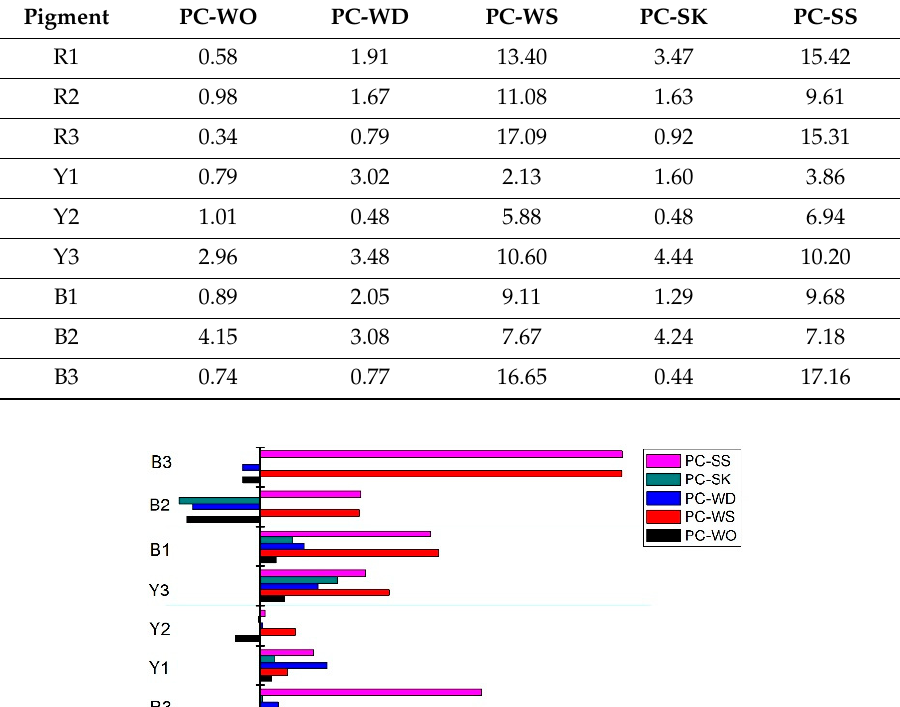
Table 7. ∆ E* ab values obtained for the scale adjustment procedures with respect to the PC one.